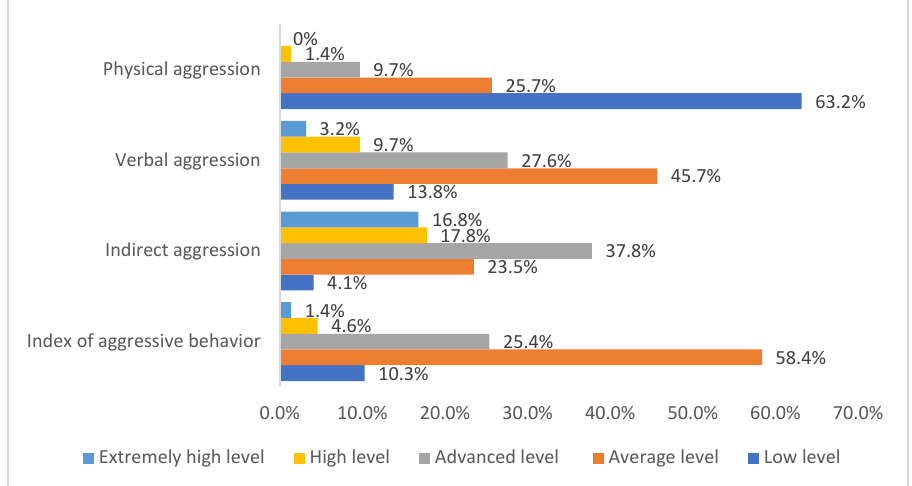
Figure 2. The frequency distribution of HCWs of COVID-19 ICU by the levels of severity of occupa- tional burnout components.